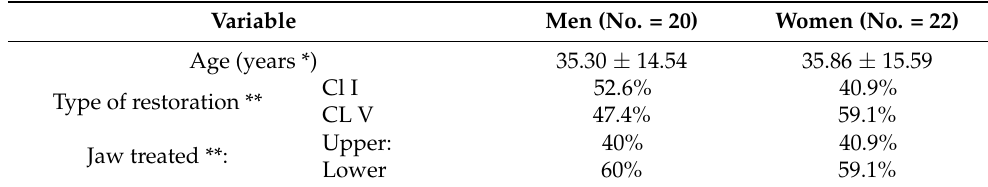
Table 1. Distribution of the type of performed restorations and treated jaw according to gender. Variable Men (No. = 20) Women (No. = 22) Age (years *) 35.30 ± 14.54 35.86 ± 15.59 52.6% 40.9% 47.4%